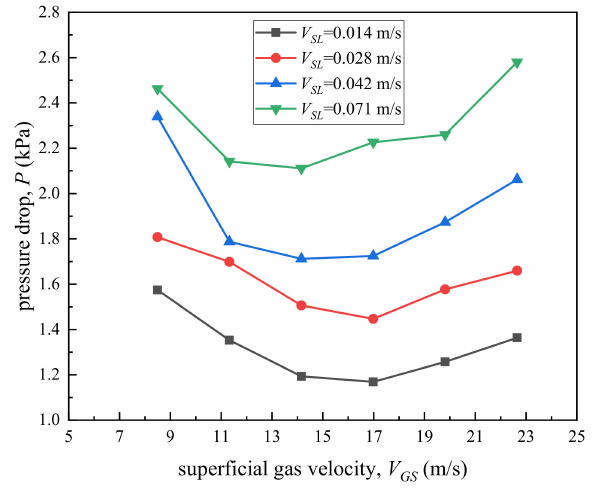
Figure 9. Variation of total pressure gradient with gas